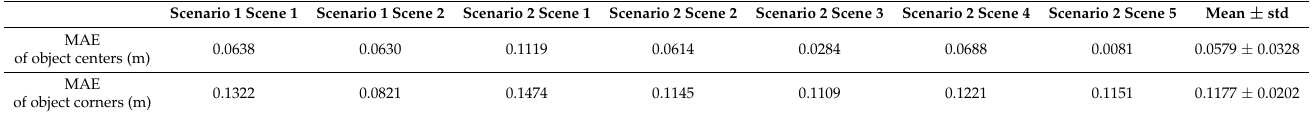
Figure 12. The alignment procedure for scenario 2, scene 4. There are four windows and one door in the indoor model and three windows and two doors in the outdoor model. The color of each element in the adjacent matrix represents the matching distance, the lighter color means a small matching distance and the darkest color means an infinite matching distance. The number in the element is the number of adjacent objects after SGDU matching. The rows and columns with all elements being invalid were eliminated (in the red line). Eventually, three windows and one door were aligned correctly. Table 3. The accuracy of indoor and outdoor model